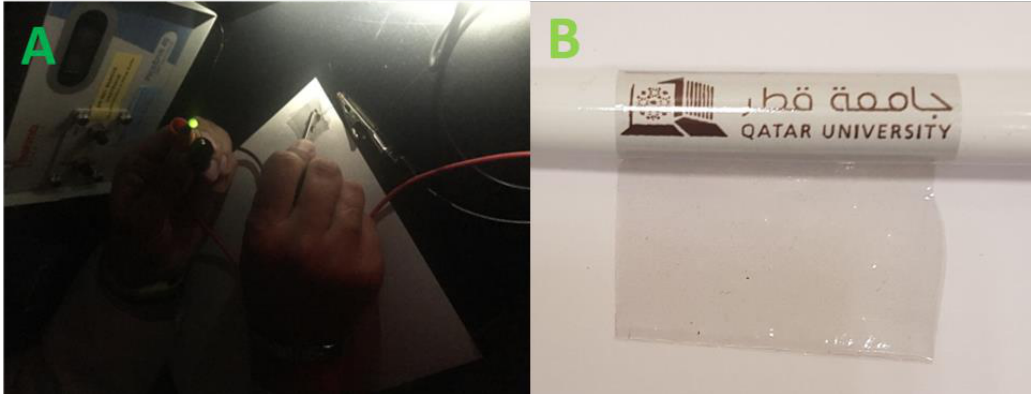
Figure 8. ( A ) The connection of coPA film containing 5 wt. % into electrical circuit. ( B ) coPA film containing 5 wt. % of MXene wrapped around a pencil.